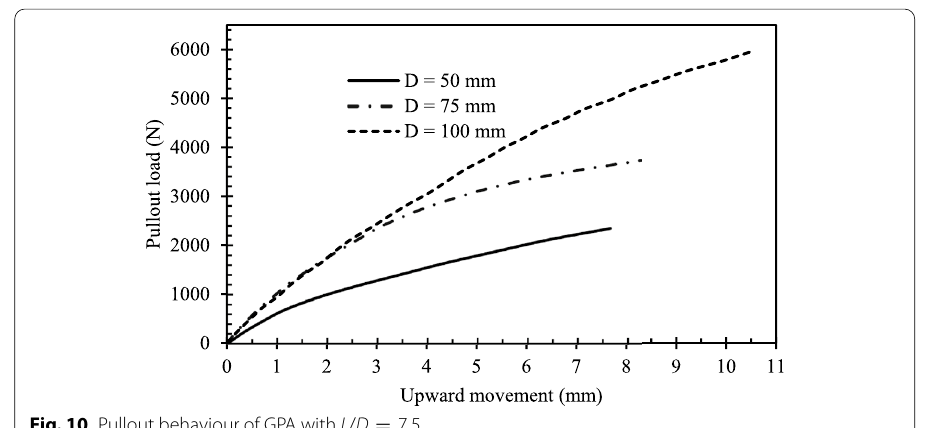
Fig. 10 Pullout behaviour of GPA with L / D